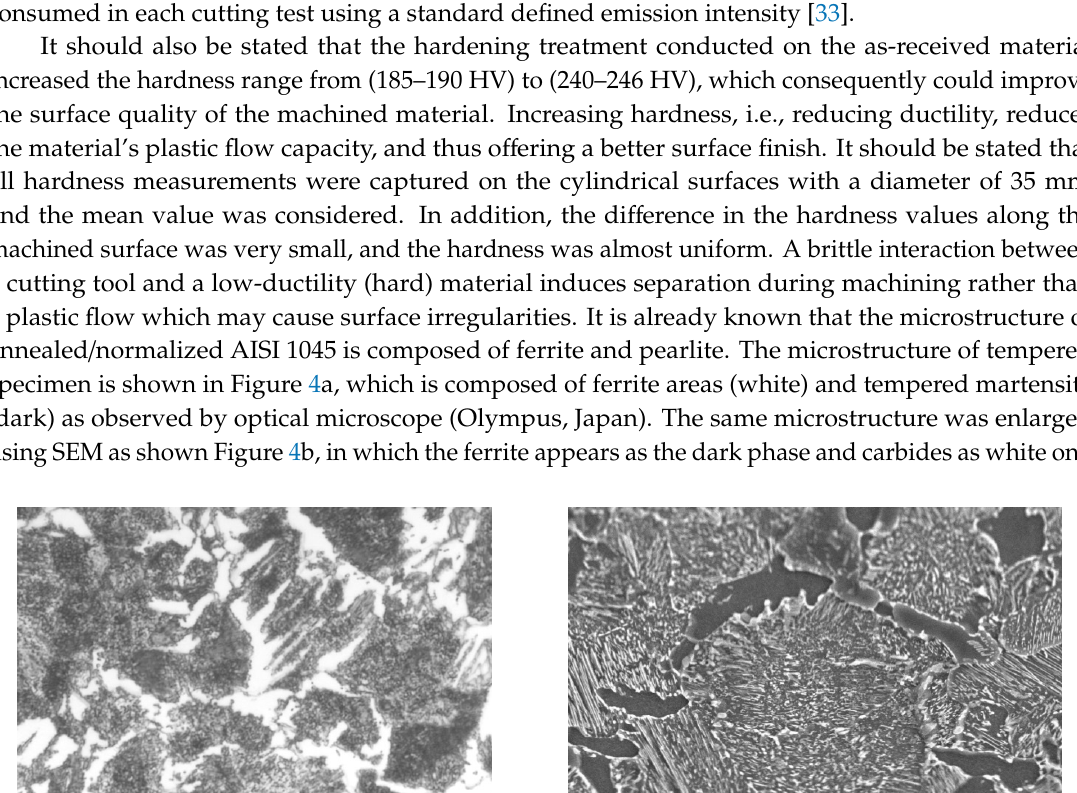
Figure 4. ( a ) Optical micrograph of tempered steel it is composed of ferrite (white) and tempered martensite (dark). ( b ) Secondary electron image of the dark area in optical micrograph (tempered martens).